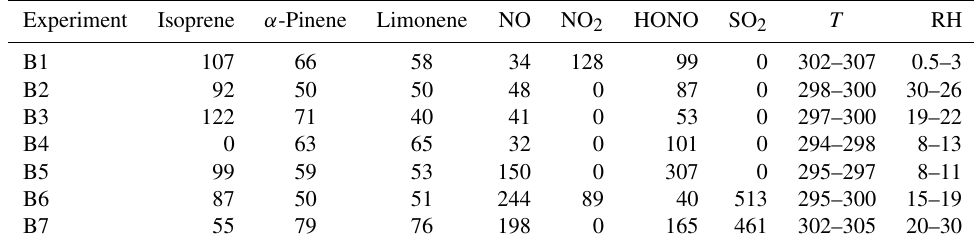
Table 1. Initial concentrations in ppb, temperature ( T ) in Kelvin and relative humidity in % for biogenic experiments.